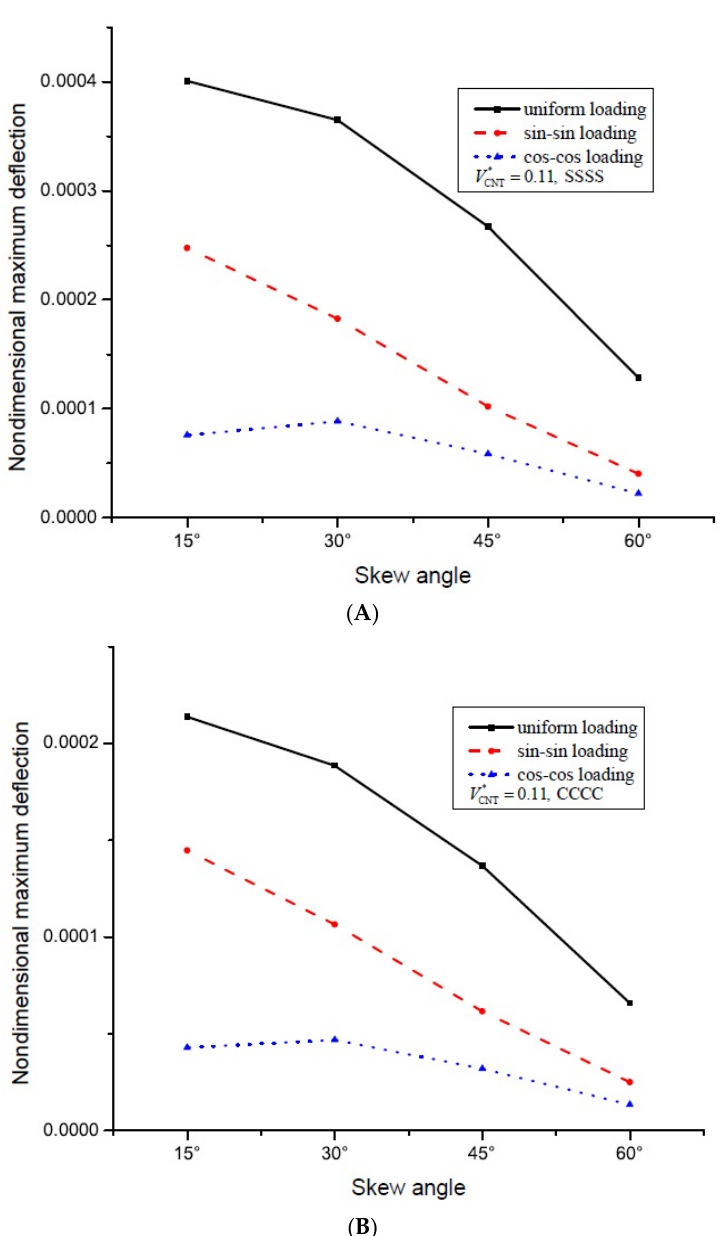
Figure 6. Variation of non-dimensional deflection of FG-V CNT-reinforced rhombic plate with the skew angle for ( A ) SSSS and ( B ) CCCC boundary condition.